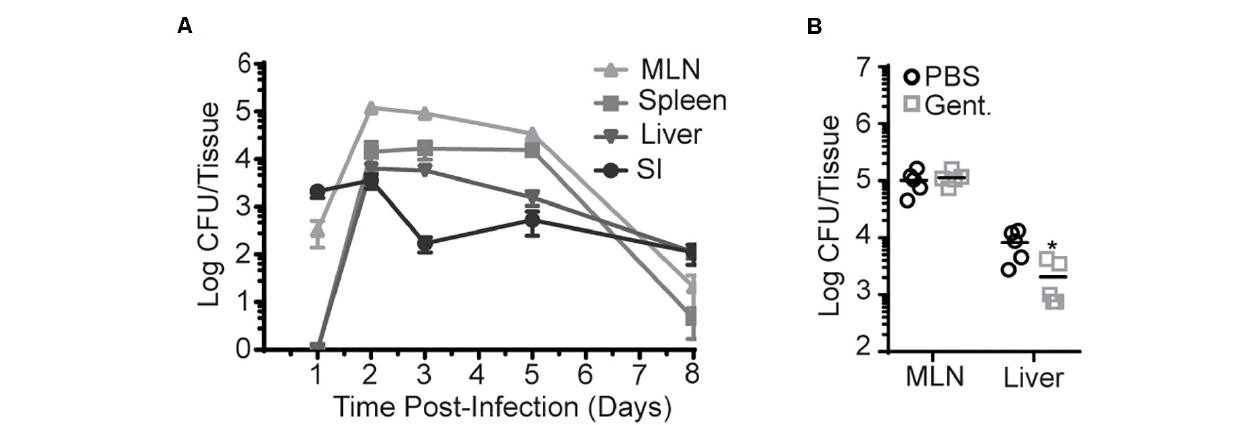
FIGURE 1 | InlA M Lm accumulation in the MLN is intracellular after foodborne infection. Bacterial burden was enumerated from the organs of Balb/c mice after oral infection with InlA M Lm 10403s. (A) Bacterial burden was enumerated from the MLN, spleen, liver, and small intestines from 1-8 dpi after infection with 2 × 10 9 CFU InlA M Lm . 1 and 3 dpi burdens have been repeated at least 3 times. The complete time course has been performed 1 time in Balb/c mice and 1 time in B6 mice ( Supplementary Figure S1A ), and 1, 3, and 5 dpi have been depicted in multiple independent experiments reported herein. (B) Mice were foodborne infected with 2 × 10 9 CFU InlA M Lm and were treated with either gentamicin or PBS at 4 hpi. At 3 dpi, MLN and livers were harvested, and bacterial burdens were quantified. (A) Data depicts 5 mice per timepoint. (B) Data are representative of 2 independent experiments containing 5 mice per group. Statistics were determined by Mann-Whitney test: * p <